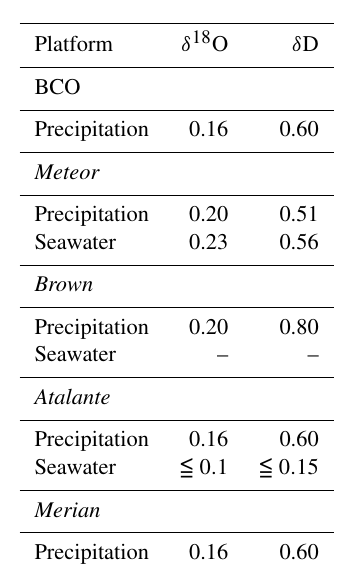
Table 1. Bulk uncertainty estimates (in units ‰) for precipitation and seawater isotope